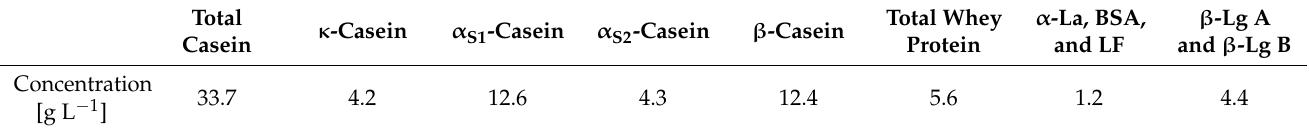
Table 1. Protein distribution in skim milk used during the